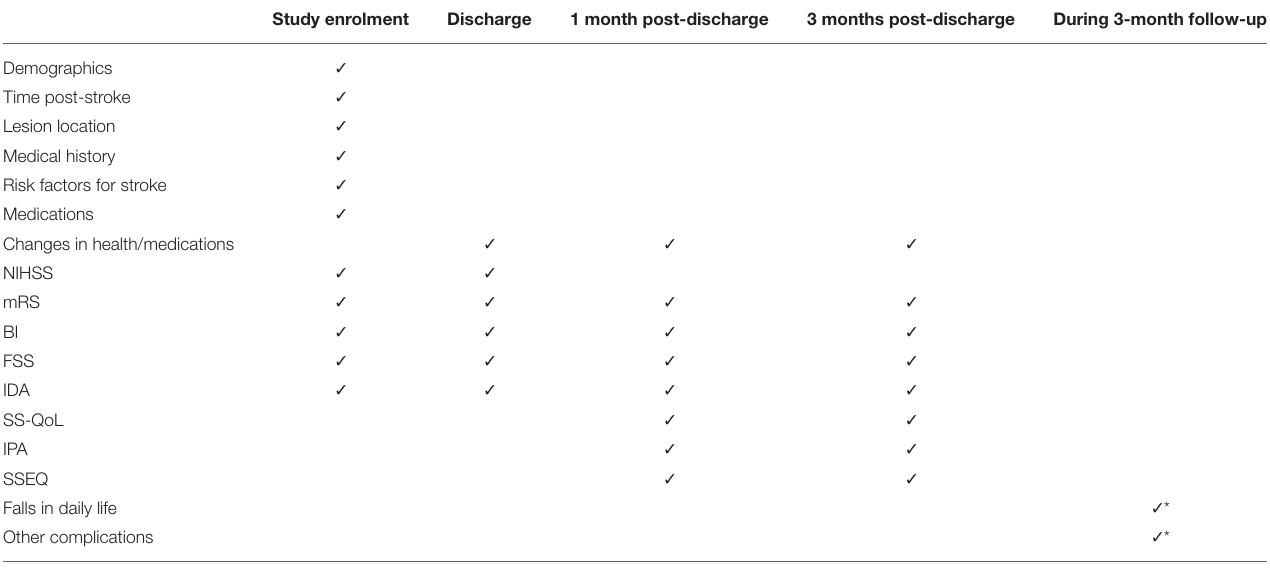
TABLE 3 | Cohort descriptors and outcome measures. Study